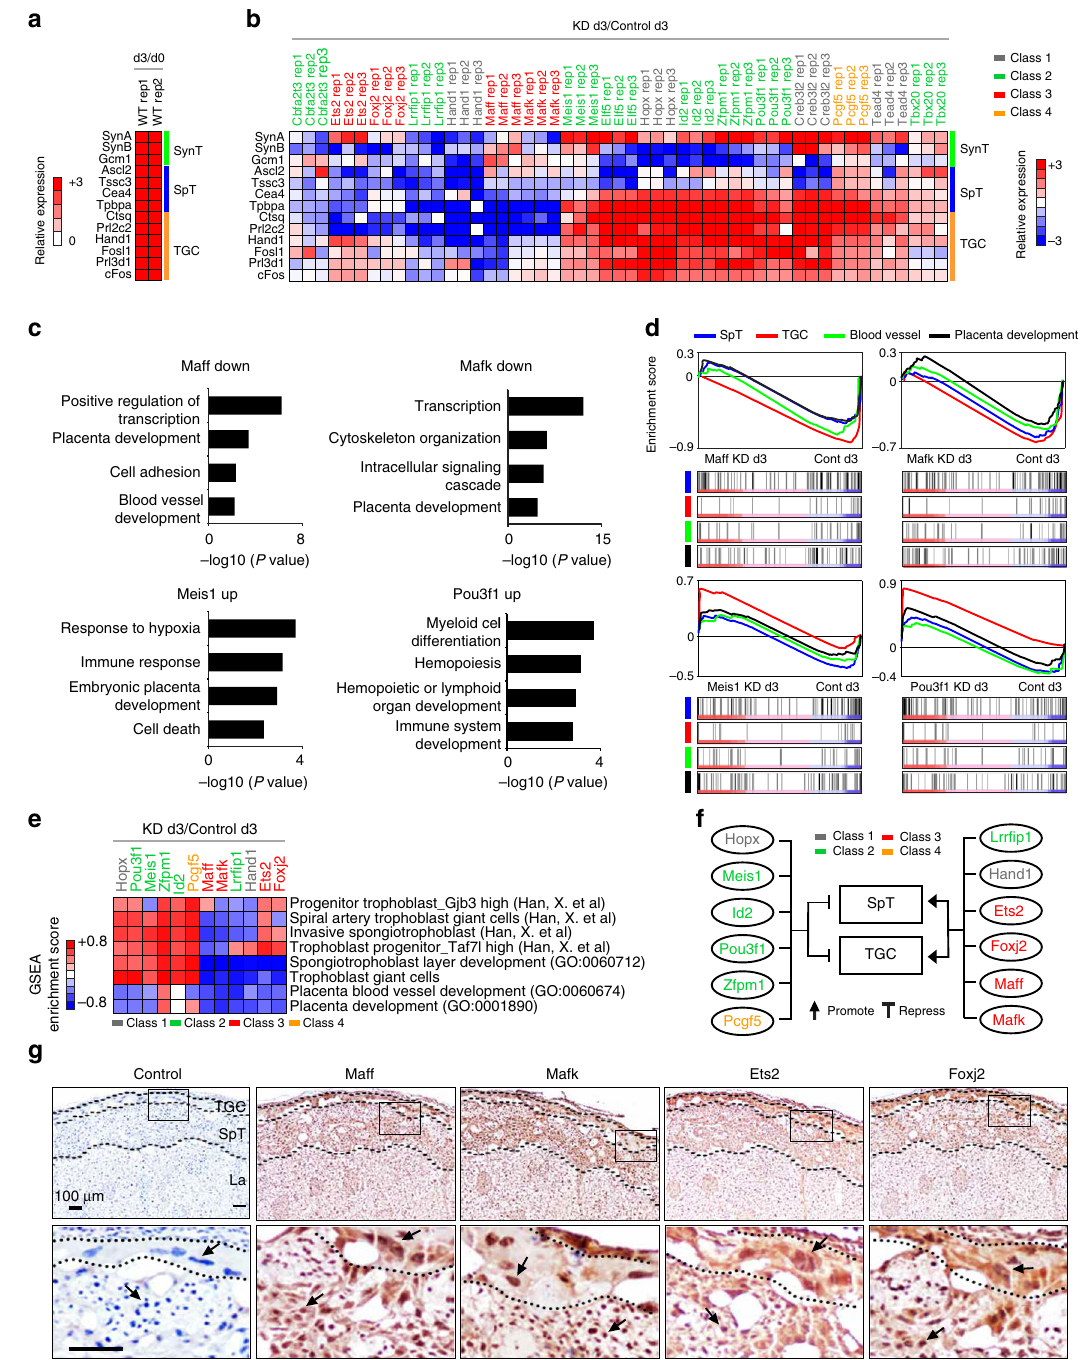
Fig. 5 Distinct roles of TSC-speci fi c TFs in lineage speci fi cation. a A heatmap showing relative expression level of each lineage markers upon differentiation (d3). Marker genes of each lineage are shown in Y -axis. b A heatmap presenting relative expression level of lineage marker genes between a TSC-speci fi c TF knockdown (KD) cells and control cells after 3 days of differentiation. X -axis shows TFs that were knocked down. Marker genes of each lineage are shown in Y -axis. c Enriched GO terms in differentially expressed genes (DEGs) that are directly regulated by TSC-speci fi c TFs. d Gene set enrichment analyses (GSEA) of global gene expression pro fi les, obtained from KD of TFs and control followed by 3 days of differentiation, on diverse groups of genes representing speci fi c placenta-related GO terms. e Heatmap showing Enrichment score from GSEA of RNA-seq data obtained from KD of TFs and control followed by 3 days of differentiation on speci fi c placenta-related terms and cell types. Red and blue colors indicate promotion and inhibition of listed terms by KD of a TF, respectively. f A schematic diagram presenting regulatory roles of a TF on lineage development of TSCs. Genes and lineages/tissues are shown with oval and rectangular shapes, respectively. Class of each TF is labeled with different colors. g Immunohistochemistry of TSC-speci fi c TFs in placenta. TGC, SpT, and La indicate trophoblast giant cell, spongiotrophoblast, and labyrinth, respectively. Each antibody used is shown at the top of the image and control indicates IgG control with hematoxylin staining. Small rectangular box in the upper panel shows an area magni fi ed (bottom panel). An arrow indicates a representative cell in trophoblast lineage and a scale bar depicts 100 µ m. Source data underlying Fig. 5a, b are provided as a Source Data fi